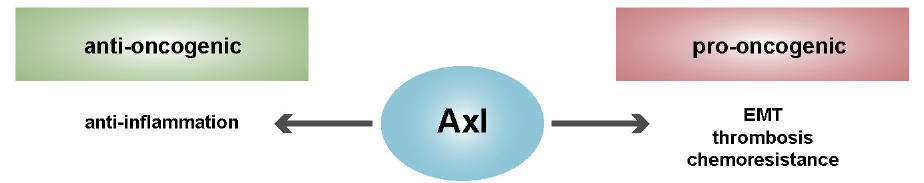
Figure 2. Dichotomy of Axl by anti- and pro-oncogenic actions. Axl prevents chronic inflammation while causing changes in epithelial cell plasticity, aggregation of platelets and escape from chemosensitivity. EMT, epithelial to mesenchymal transition.